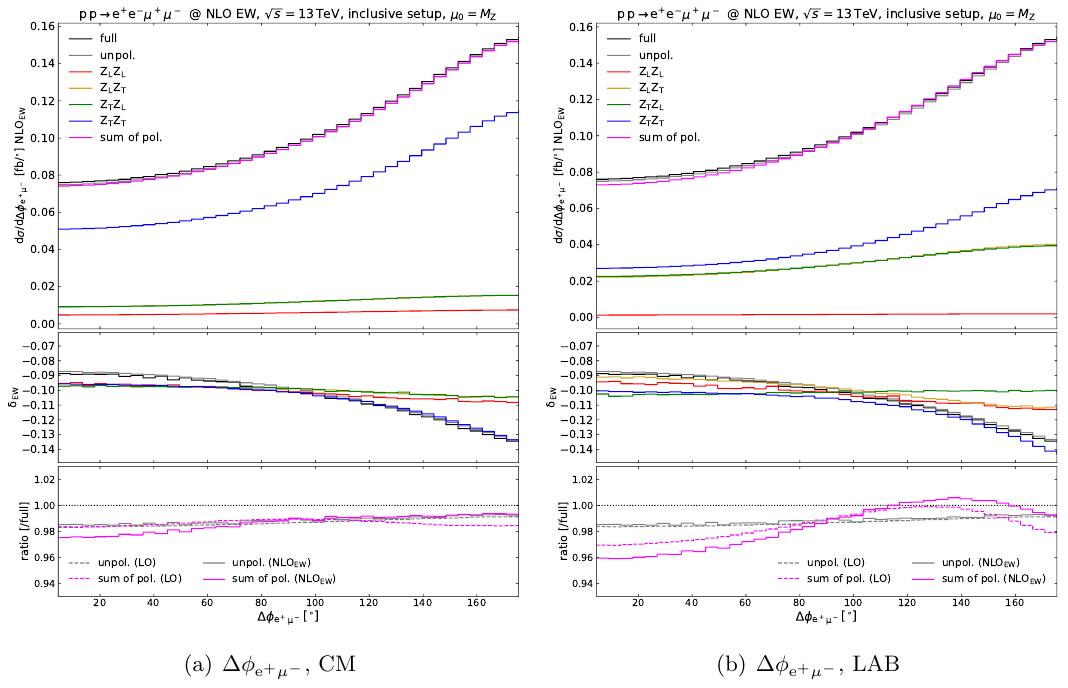
Figure 7 . Distributions in the azimuthal separation between the positron and the muon. Polar- izations are defined the CM (a) and in the LAB (b) frame. Same structure as in figure 6.